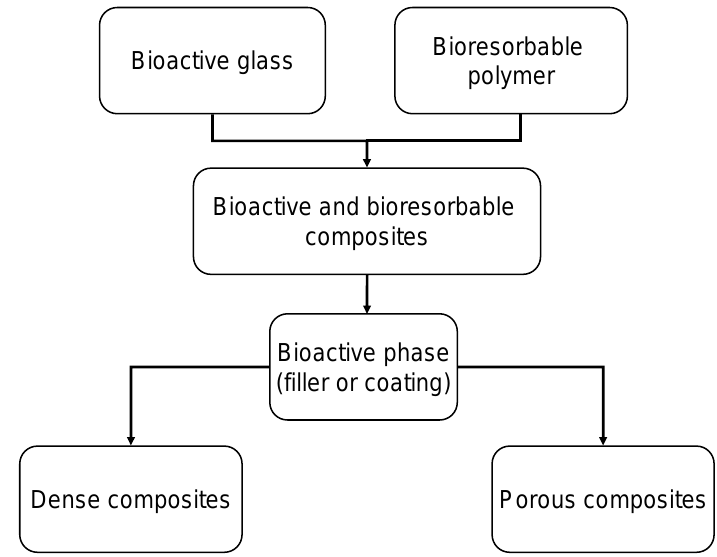
Figure 12. Schematic diagram showing the types of synthetic bioactive and biodegradable polymer composite scaffolds for bone tissue engineering applications (modified after reference